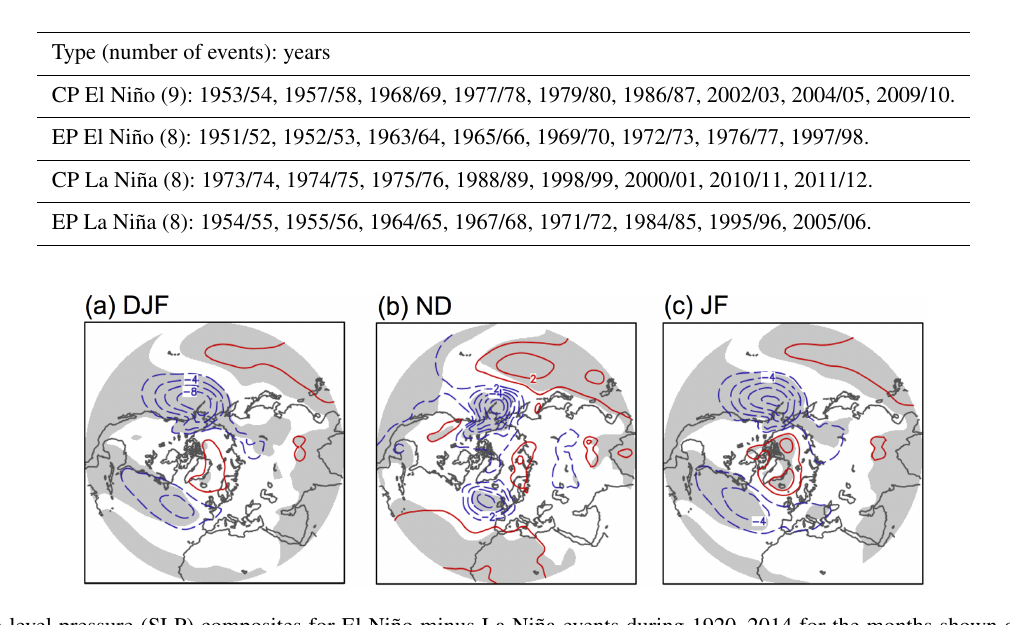
Table 2. Central Pacific (CP) and eastern Pacific (EP) ENSO events (following Zhang et al., 2018) used for calculating the composites in Fig. A5. See also Sect. 3.2.